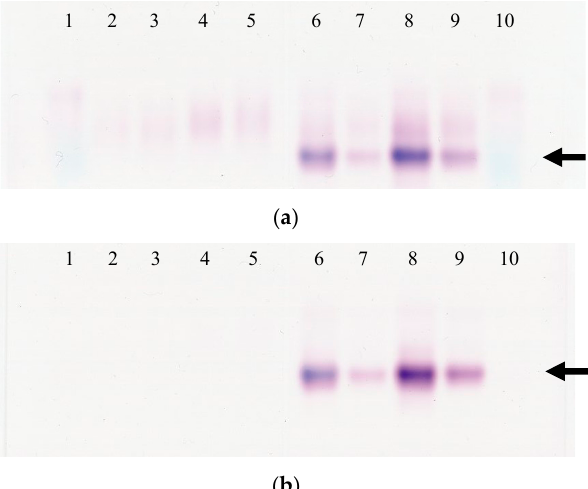
Figure 5. Electrophoretic patterns of alkaline phosphatase (ALP) isozyme in rat serum. ( a ) Gel not treated with levamisole. 1. control serum (human serum), 2. fed mouse serum (serum ALP 152 U/L analyzed by the JSCC method), 3. fasted mouse serum (207 U/L), 4. fed mouse serum (483 U/L), 5. fasted mouse serum (463 U/L), 6. fed rat serum (1021 U/L), 7. fasted rat serum (398 U/L), 8. fed rat serum (1401 U/L), 9. fasted rat serum (945 U/L), 10. control serum (human serum). ( b ) Gel treated with levamisole. 1. control serum (human serum), 2. fed mouse serum (serum ALP 152 U/L analyzed by the JSCC method), 3. fasted mouse serum (207 U/L), 4. fed mouse serum (483 U/L), 5. fasted mouse serum (463 U/L), 6. fed rat serum (1021 U/L), 7. fasted rat serum (398 U/L), 8. fed rat serum (1401 U/L), 9. fasted rat serum (945 U/L), 10. control serum (human serum). The arrow indicates the intestinal ALP band.